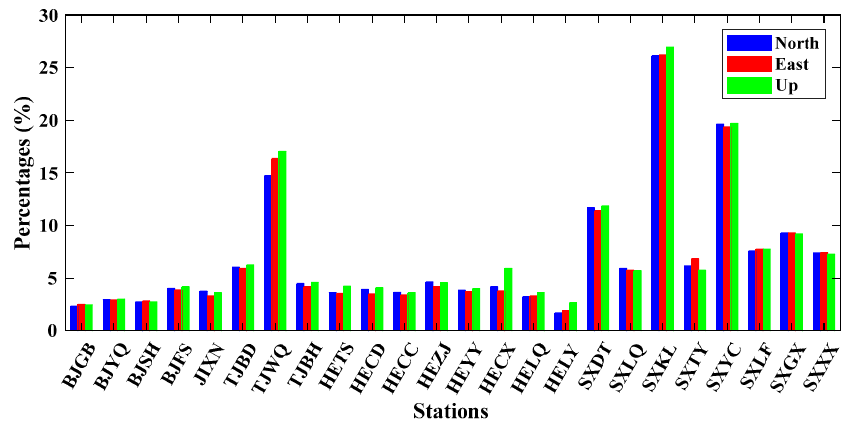
Figure 2. GNSS time series with missing data at station SXKL.